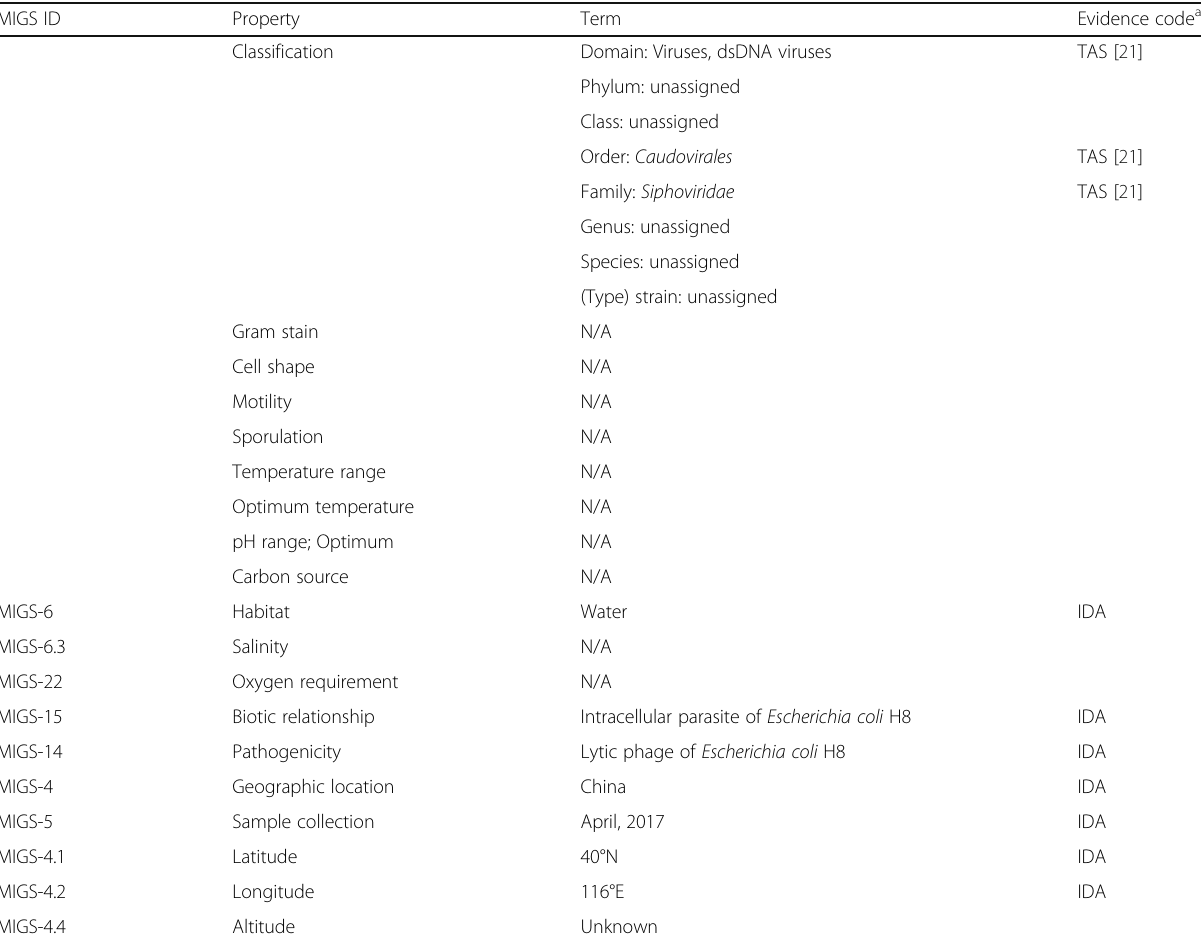
Table 1 Classification and general features of Genusspecies strain designation T [19]